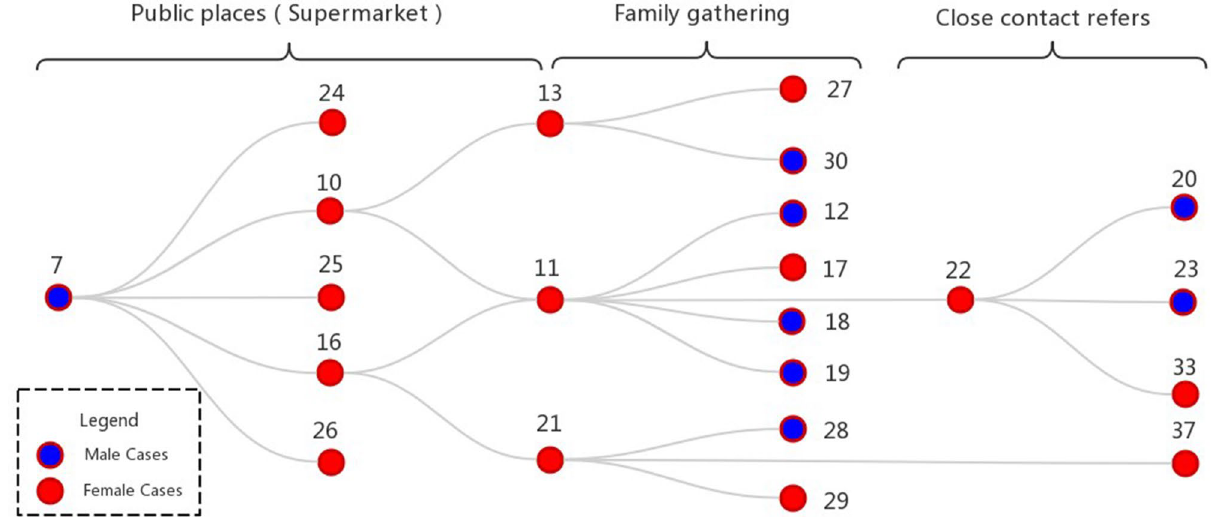
Figure 5. The epidemic spreading network of a typical COVID-19 super spreader in Liaocheng City. Note Close contact refers to infection without clear social